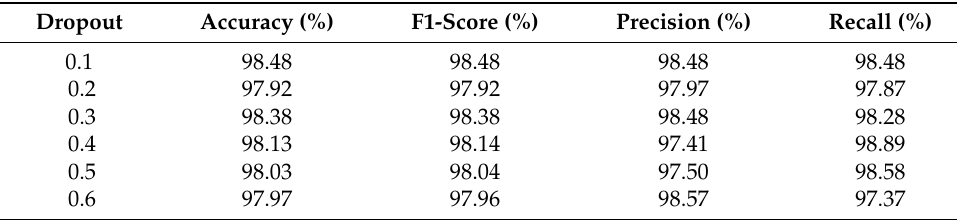
Table 5. Performance of multi-level perceptron on varying the dropout rate.